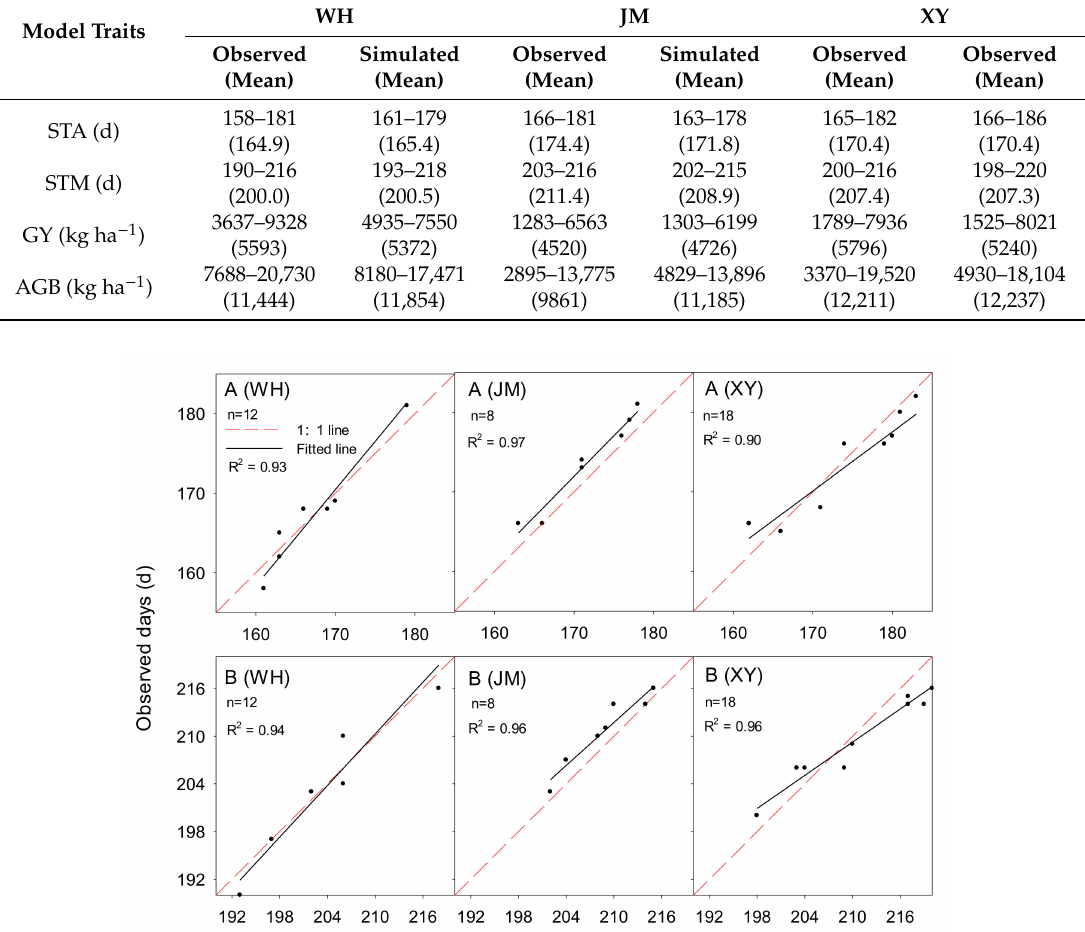
Table 6. The range of the APSIM-wheat simulated and observed values for growth duration from sowing to anthesis (STA) and maturity (STM), grain yield (GY), and above-ground biomass (AGB) in the Wuhan (WH), Jingmen (JM), and Xiangyang (XY) regions in Hubei province.